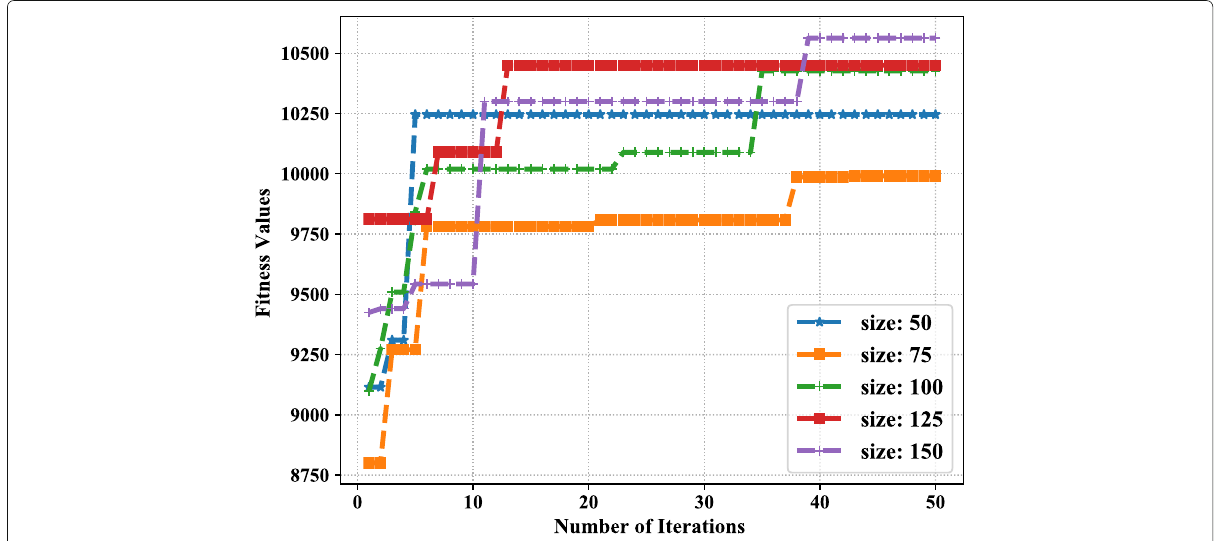
Fig. 8 Fitness values with different values of population size